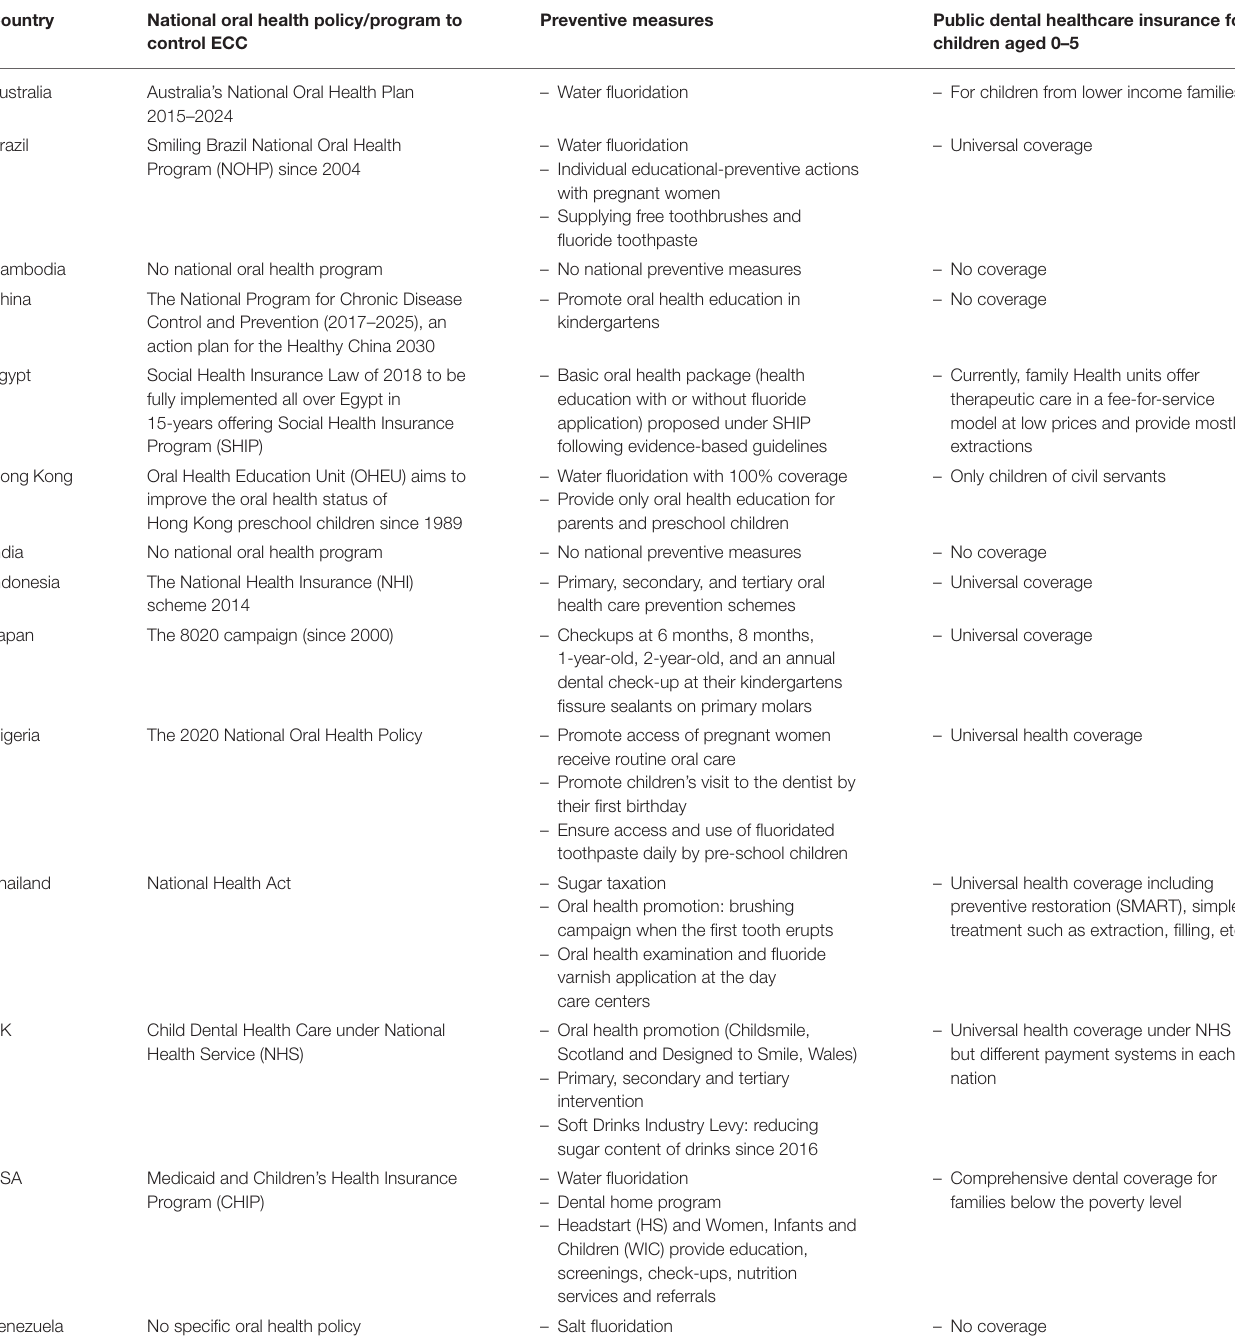
TABLE 3 | Updated oral health policies related to ECC in each country/region.